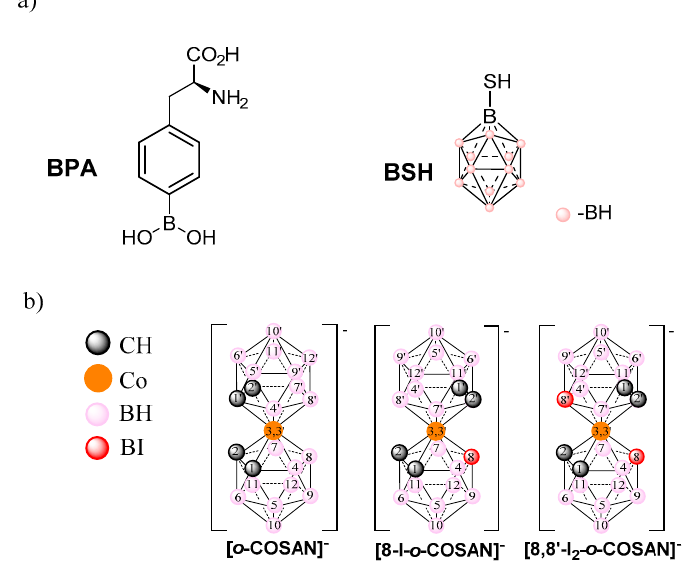
Figure 1. Schematic representation: ( a ) BPA and BSH, clinically used in the treatment of cancer with BNCT; ( b ) the sodium salts of cobaltabis(dicarbollide) clusters [3,3 (cid:48) -Co(1,2-C 2 B 9 H 11 ) 2 ] − , [3,3 (cid:48) -Co(8- I-1,2-C 2 B 9 H 10 )(1 (cid:48) ,2 (cid:48) -C 2 B 9 H 11 )] − , and [3,3 (cid:48) -Co(8-I-1,2-C 2 B 9 H 11 ) 2 ] − , abbreviated as [ o -COSAN] − , [8-I- o -COSAN] − , and [8,8 (cid:48) -I 2 - o -COSAN] − ,